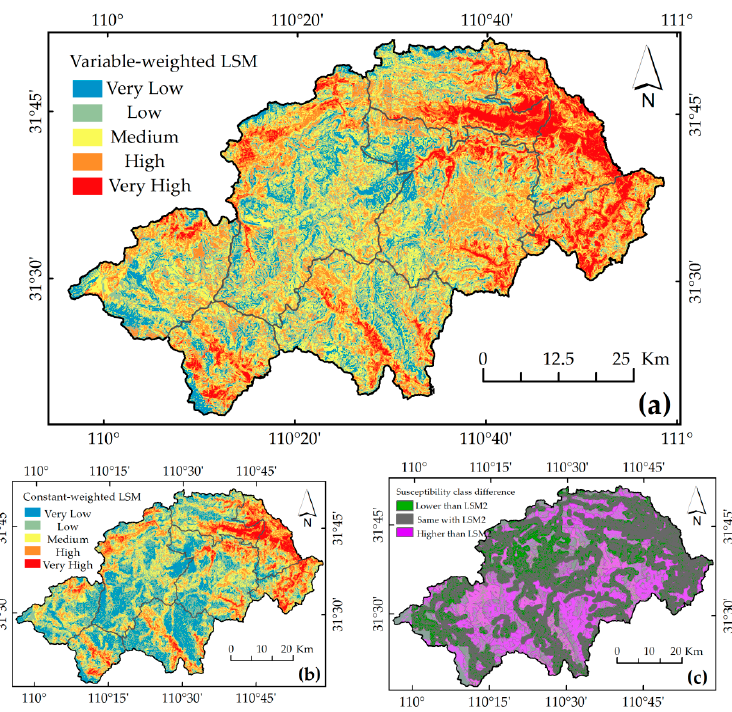
Figure 7. Landslide susceptibility maps: ( a ) LSM1 (using variable weights); and ( b ) LSM2 (using constant weights); and ( c ) susceptibility class difference (produced using ArcGIS